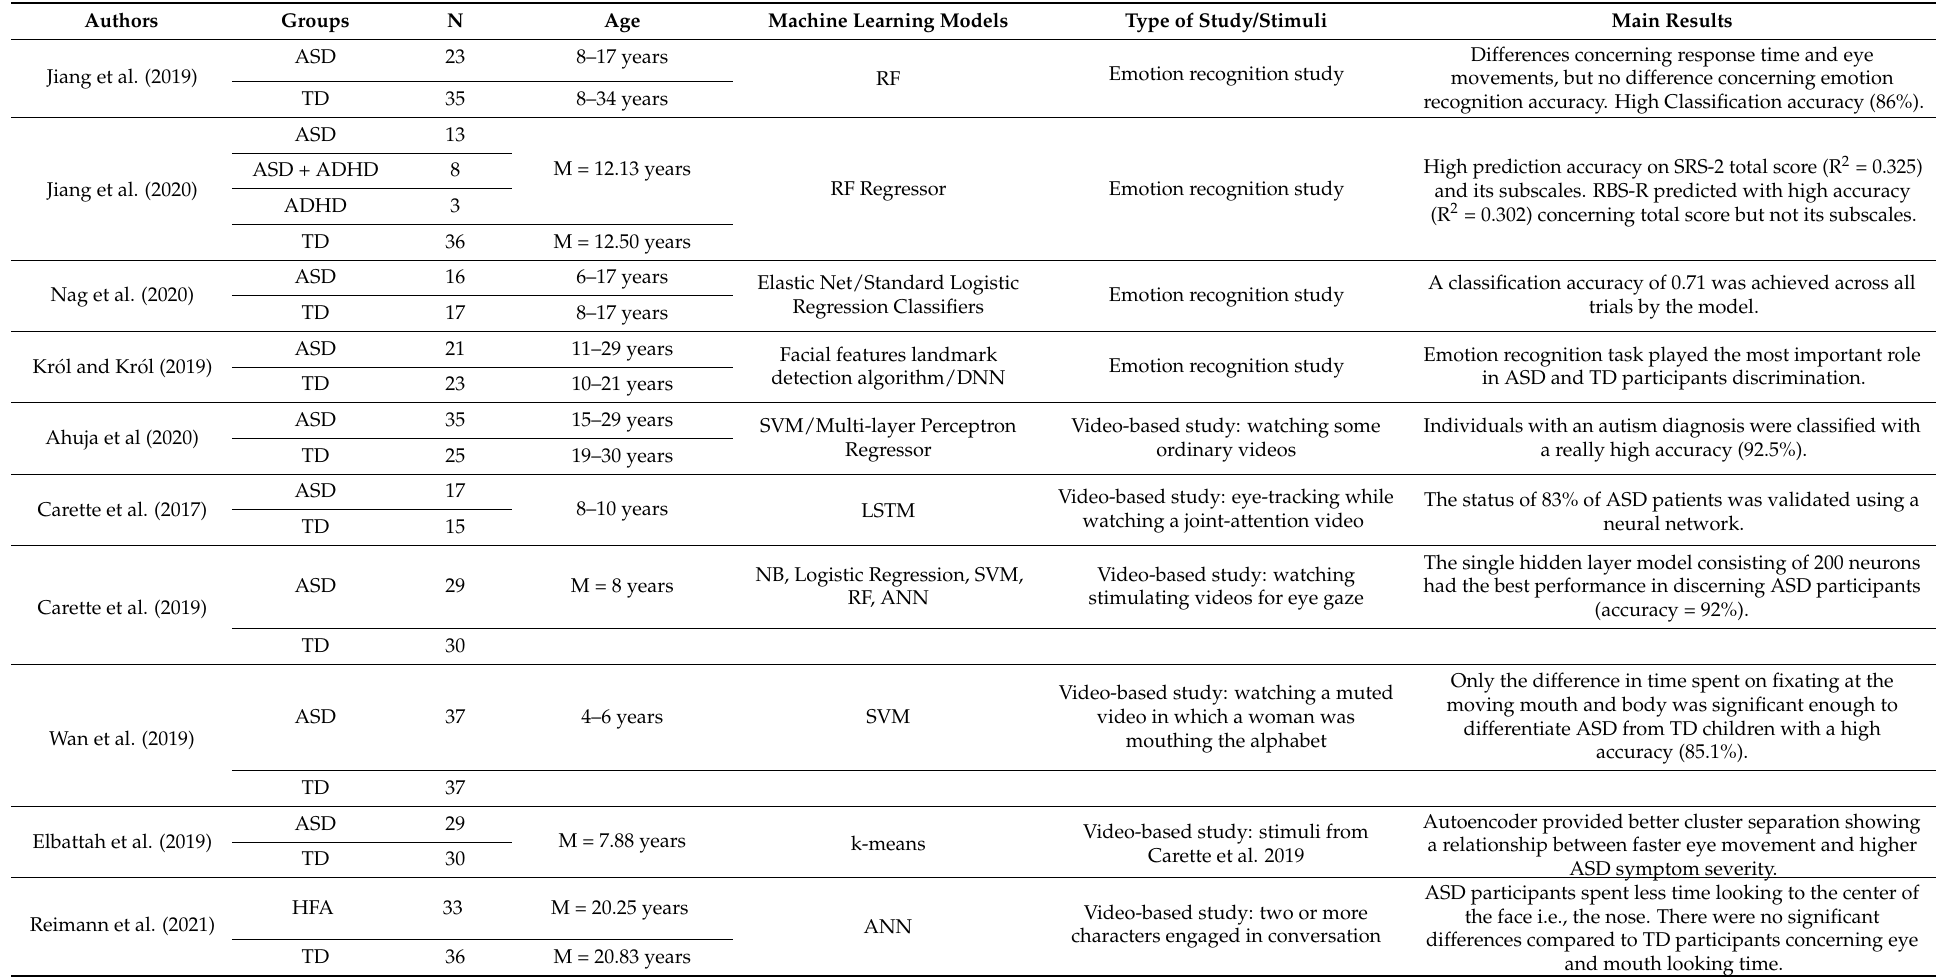
Table 1. Selected